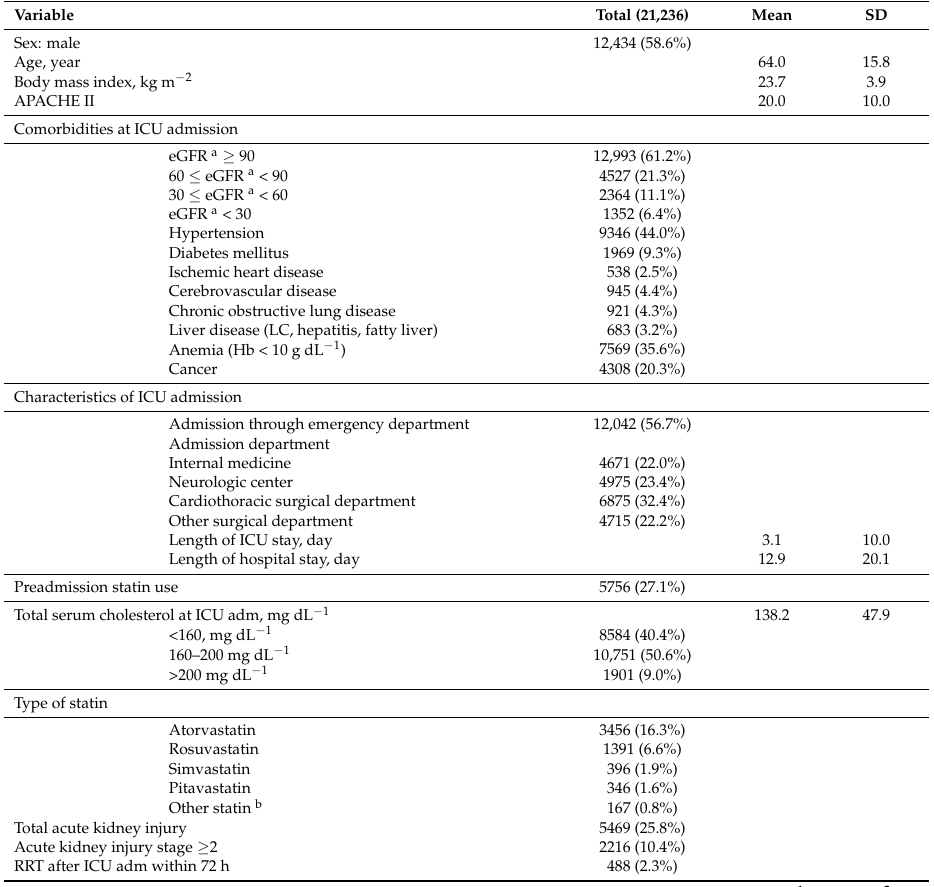
Table 1. Baseline characteristics of adults patients who were admitted to ICU in 2012–2017.